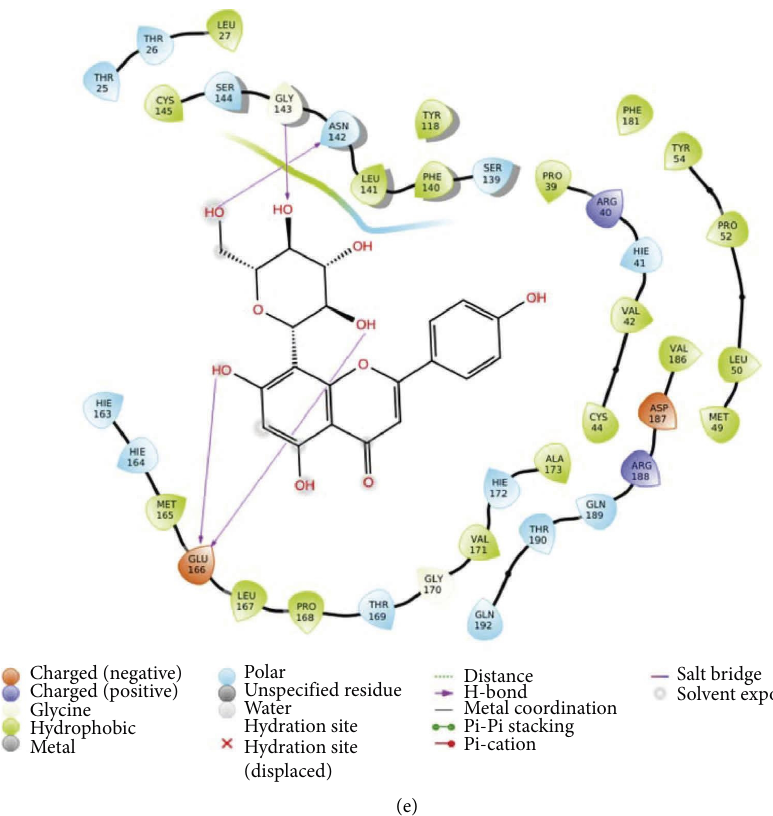
Figure 3: Ligand-protein 2D interaction diagram of molecular docking. (a) Quercetin (control), (b) procyanidin, (c) oleic acid, (d) methyl linoleic acid, and (e)